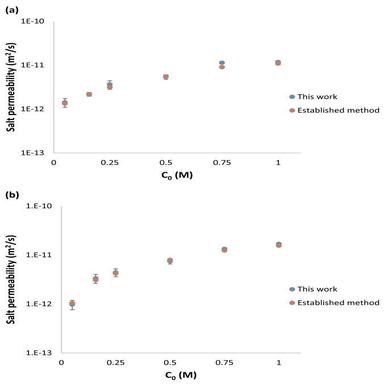
Comparison of salt permeability estimated from the novel procedure presented in this work and the salt diffusion measurements in the case of Fujifilm Type 10 membranes: a) CEM and b) AEM.